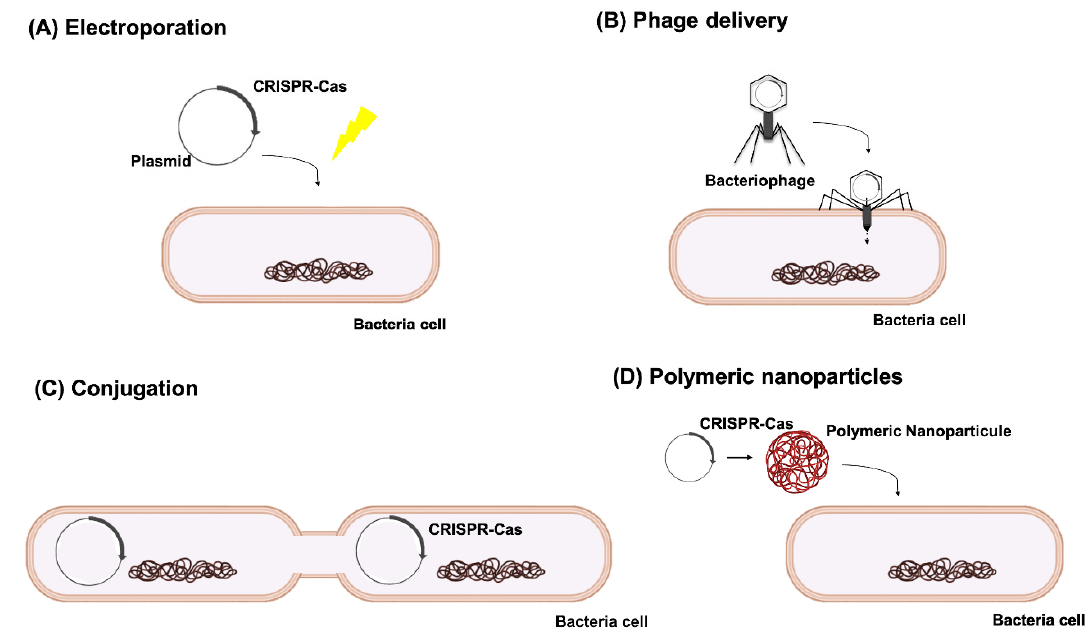
Figure 5. Different means of CRISPR-Cas delivery into the target cells: ( A ) plasmid electroporation, ( B ) phage delivery, ( C ) conjugation and ( D ) polymeric nanoparticles.